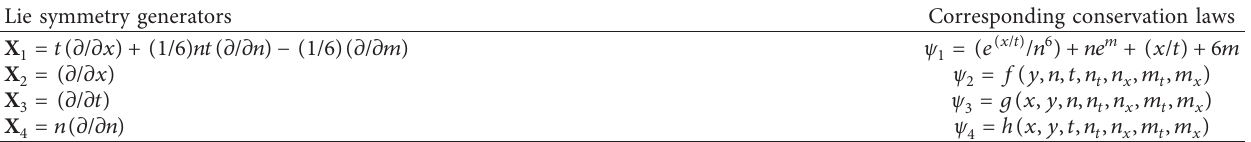
Table 8: Lie symmetry generator and corresponding conservation laws.